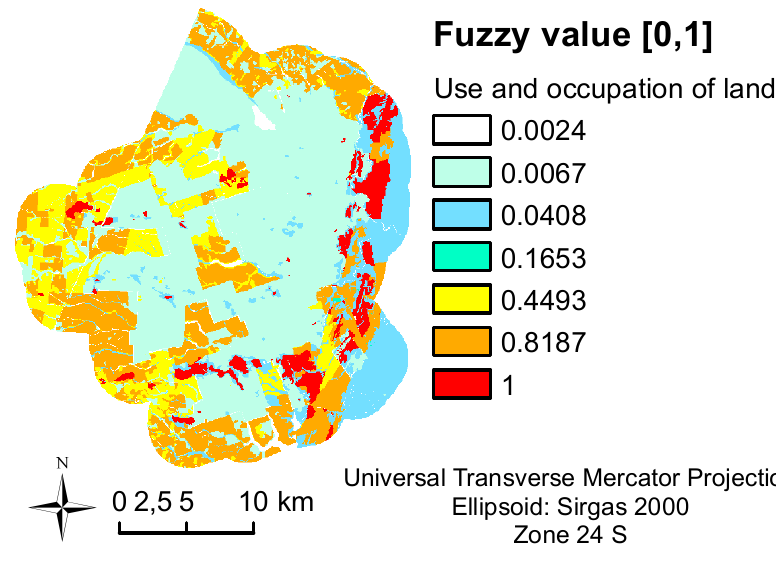
Figure 4. Effect of the fuzzy Gaussian function on fire risk probability in different land